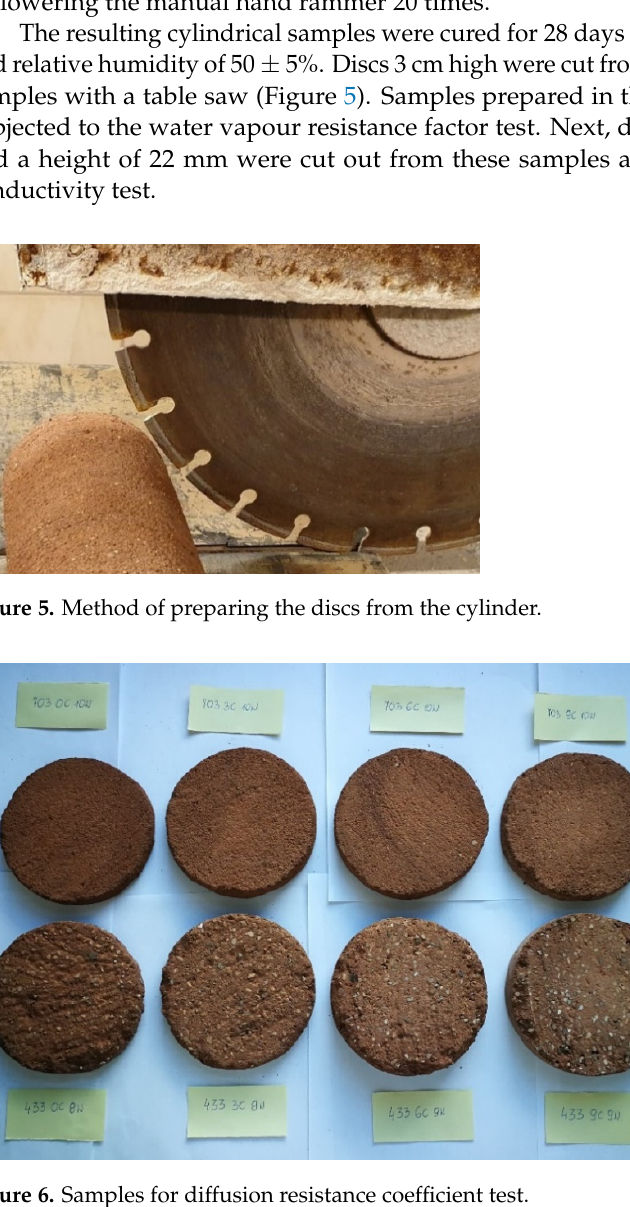
Table 3. Mineral composition of soil mixtures used in tests.